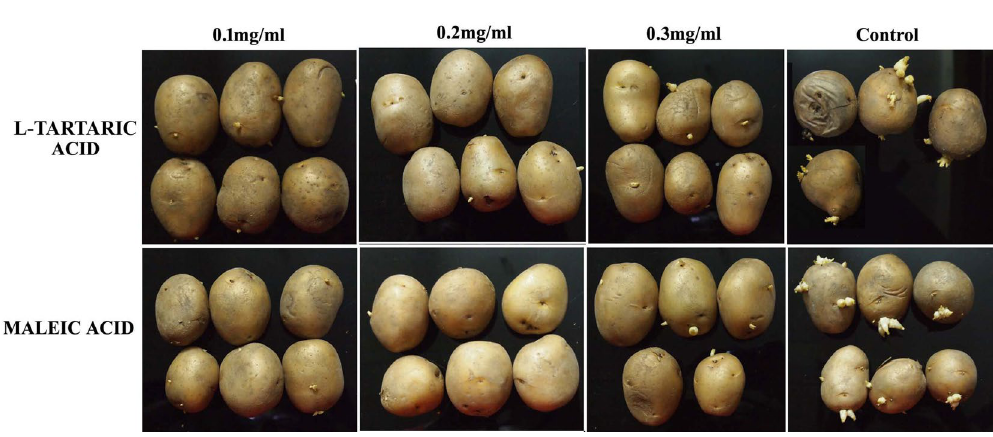
Figure 1. Effect of maleic acid and l-tartaric acid at different concentrations (ranging from 0.1 to 0.3 mg/ml) on potato tubers after 6 weeks of storage at room temperature in